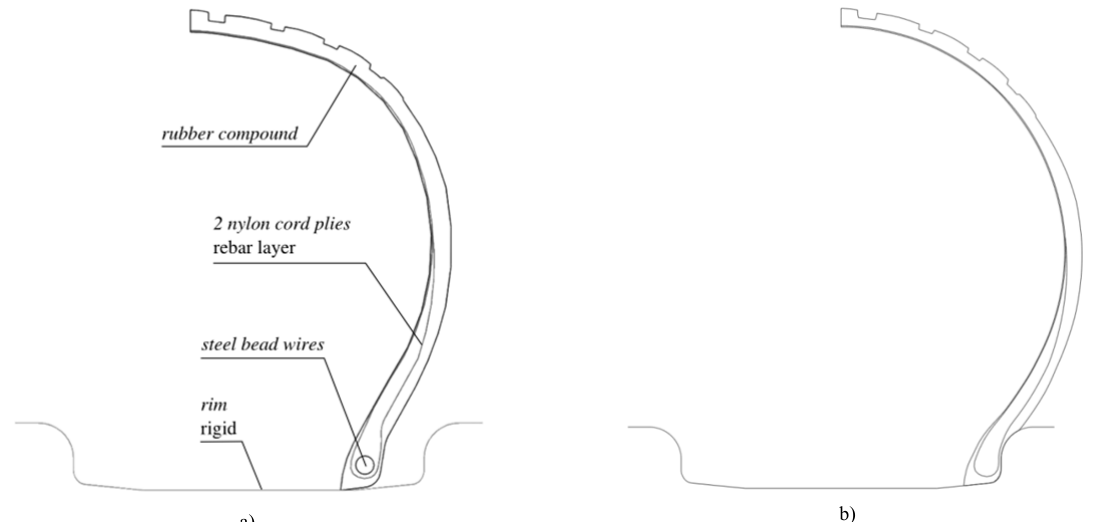
Fig. 4 Axisymmetric model of bias-ply tyre: a) Initial, unstressed state and b) after mounting and inflation